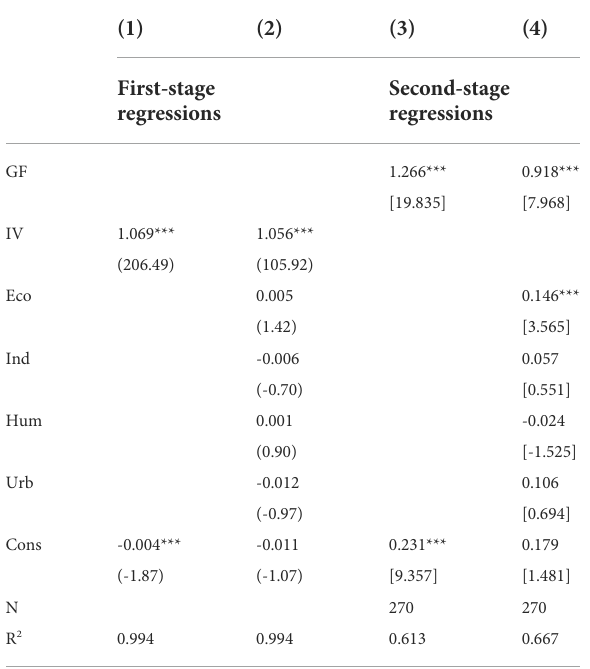
TABLE 5 IV estimation result. TABLE 6 Replace variable